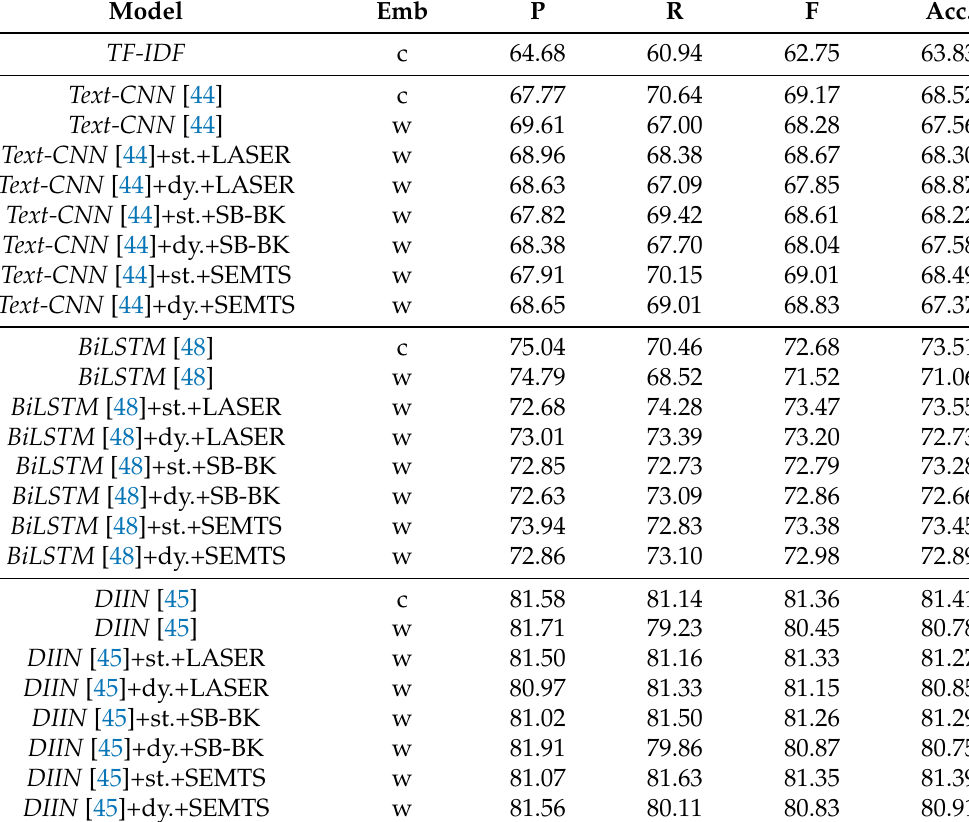
Table 6. The comparison between our method and other models on